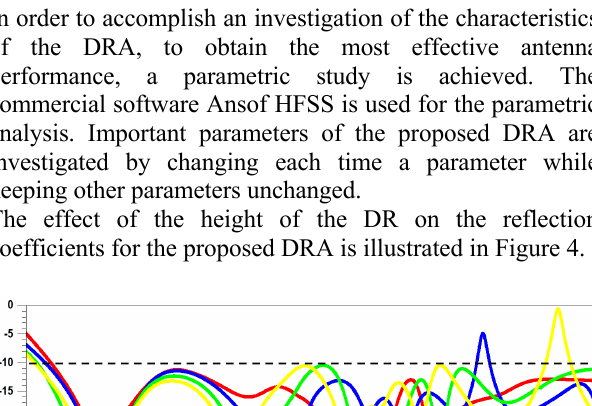
Figure 5: Simulated reflection coefficient for various length of L ST1 .